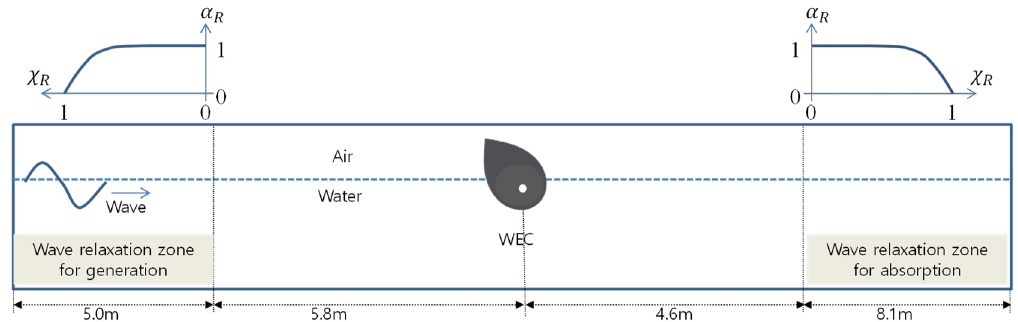
Figure 3. Two-dimensional schematic of an asymmetric WEC in a numerical wave tank.